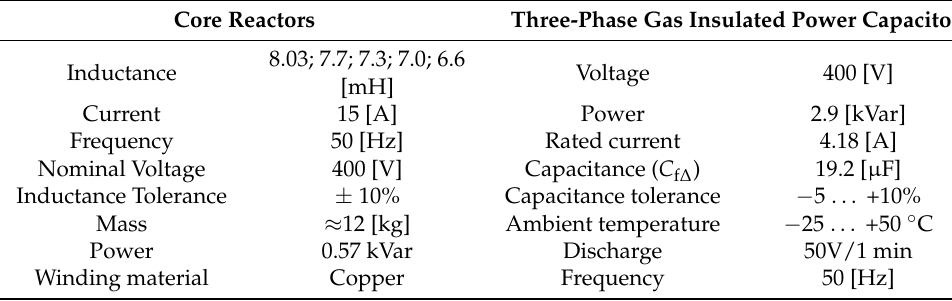
Table 2. Technical data of the filter reactors and capacitor (from manufacturer).